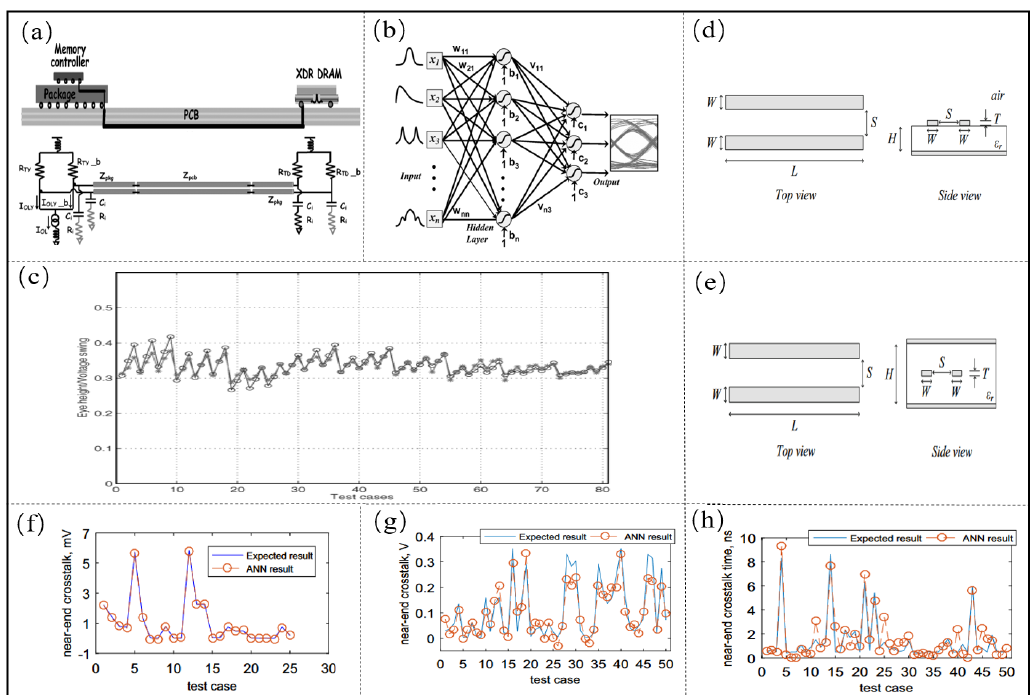
Figure 3. ( a ) Short-channel XDR memory system. Adapted with permission from [57]. ( b ) Established ANN model. Adapted with permission from [57]. ( c ) Eighty-one test cases to verify the approximation capabilities of the ANN. Adapted with permission from [57]. ( d ) Geometrical structure of a coupled stripline. Adapted with permission from [37]. ( e ) Geometrical structure of a coupled stripline. Adapted with permission from [37] ( f ) Testing result of the ANN for crosstalk in striplines. Adapted with permission from [37]. ( g ) Maximum near-end crosstalk voltage comparison results. Adapted with permission from [37]. ( h ) Comparison of maximum near-end crosstalk occurrence time results. Adapted with permission from